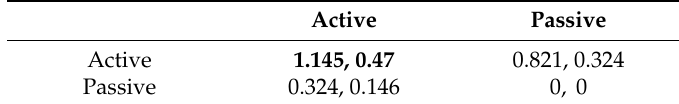
Table 9. Payo ff matrix A for 2 × 2 (Scrum Master vs. OTM) game for the partial e ff ective team with L = 0.675, P = 0.72, C = 0.25, α = 0.55, β = 0.45.